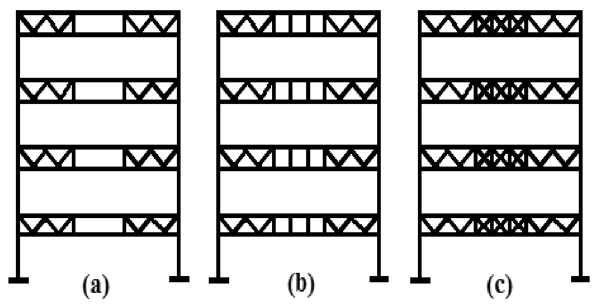
Fig. 1 The frame with special truss beams